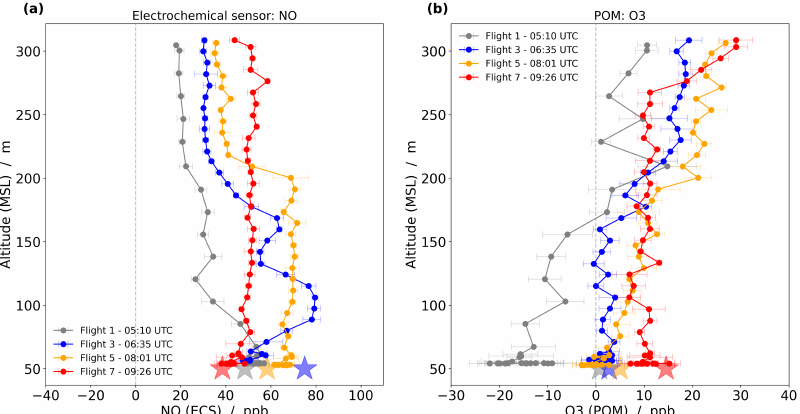
Figure 10. Vertical profiles of NO ( a ) and O 3 ( b ) of four consecutive flights near the motorway in the morning hours (times in the legend, local time: UTC + 2) on 22 September 2021. The drone rising velocity is 1 m · s − 1 . Stars indicate mean mole fractions obtained from ground-based measurement stations located on the same side of the motorway as the flight